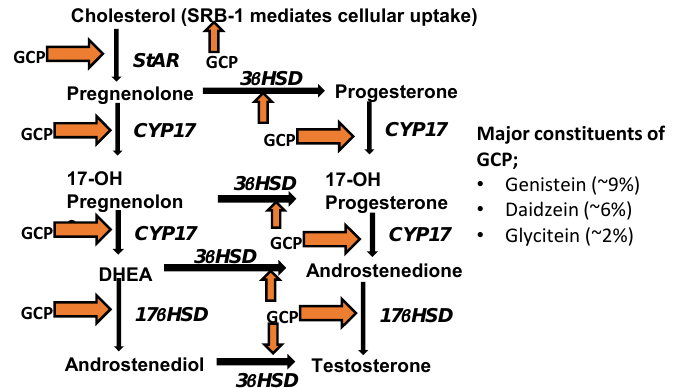
Figure 6. Overview of testosterone synthesis. Our data indicate that GCP is able to inhibit the expression of several enzymes required for testosterone synthesis, including SRB-1, StAR, Cyp17, 3 β HSD, and 17 β HSD. The primary constituents of GCP are genistein (~9%), daidzein (~6%), and glycitein